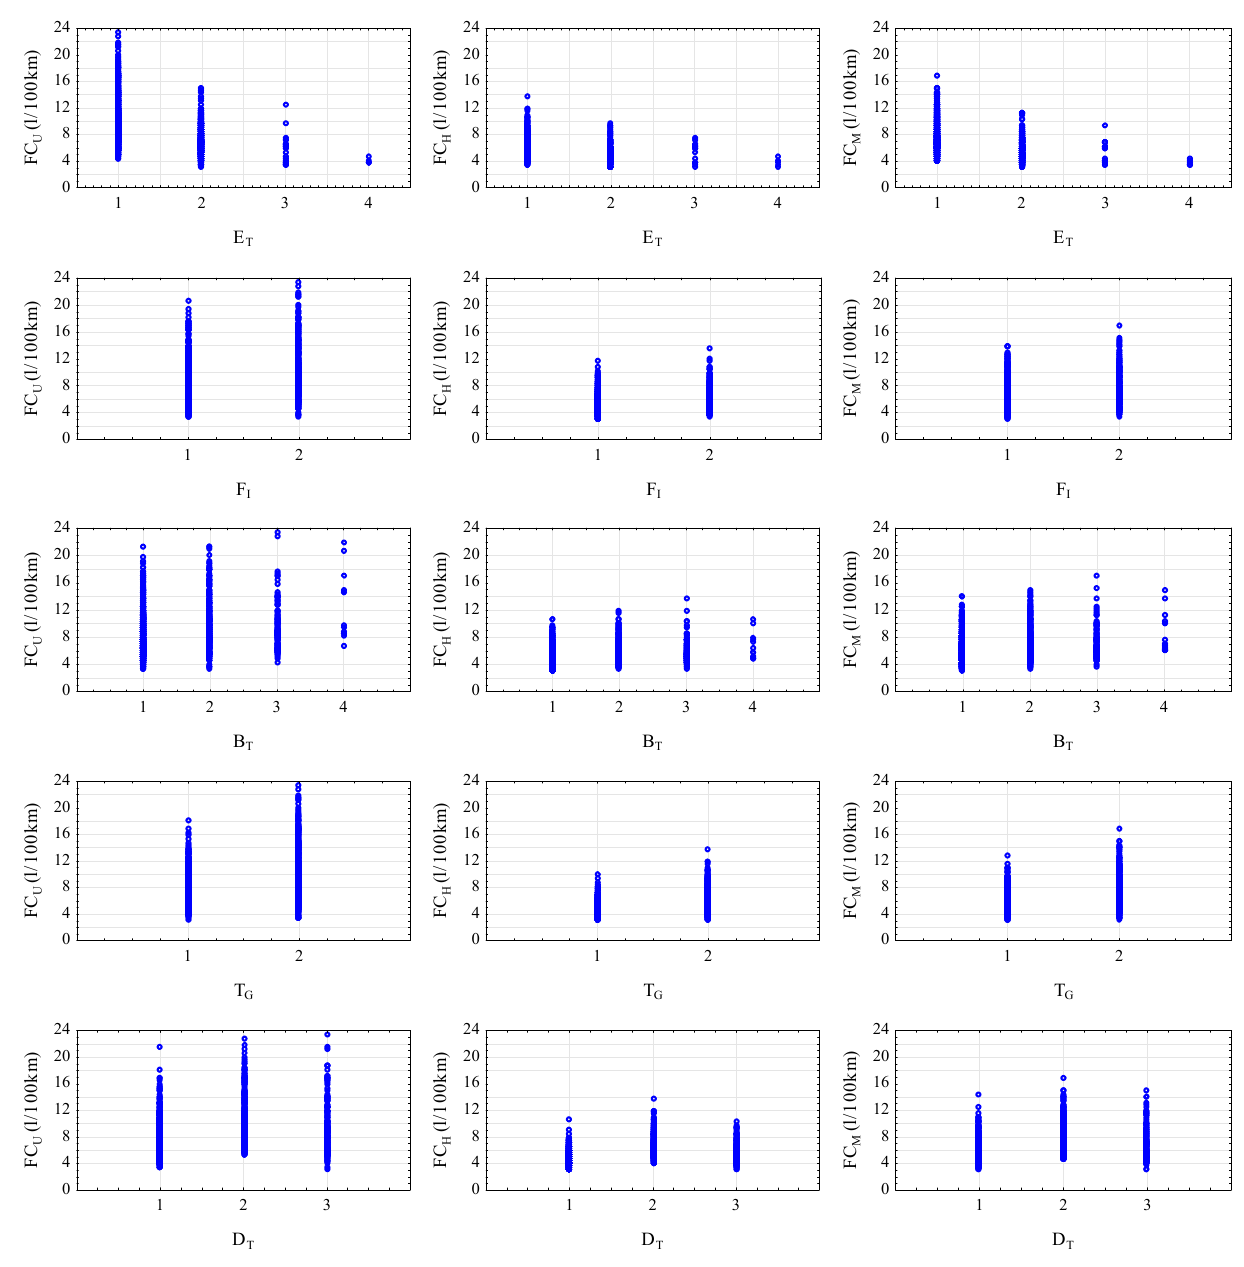
Figure 3. Fuel consumption depending on the qualitative input variables.